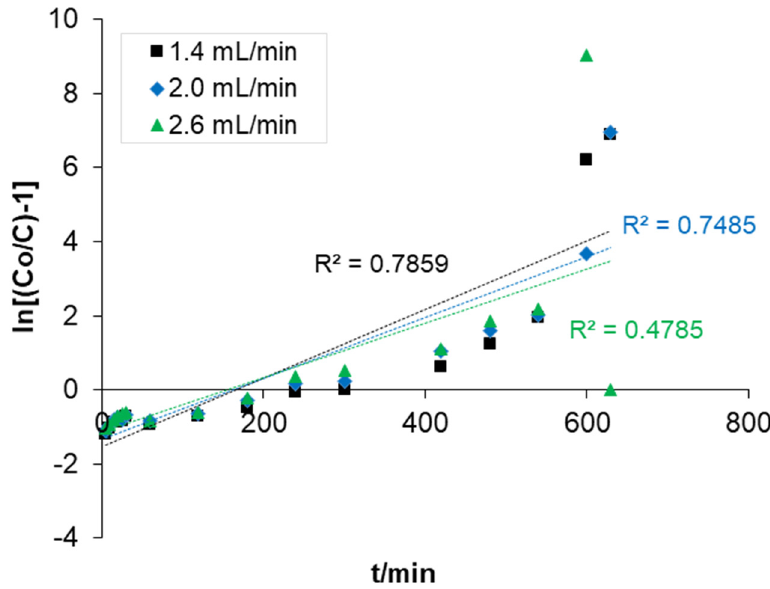
Figure 6. Linear plot of the Yoon–Nelson model.